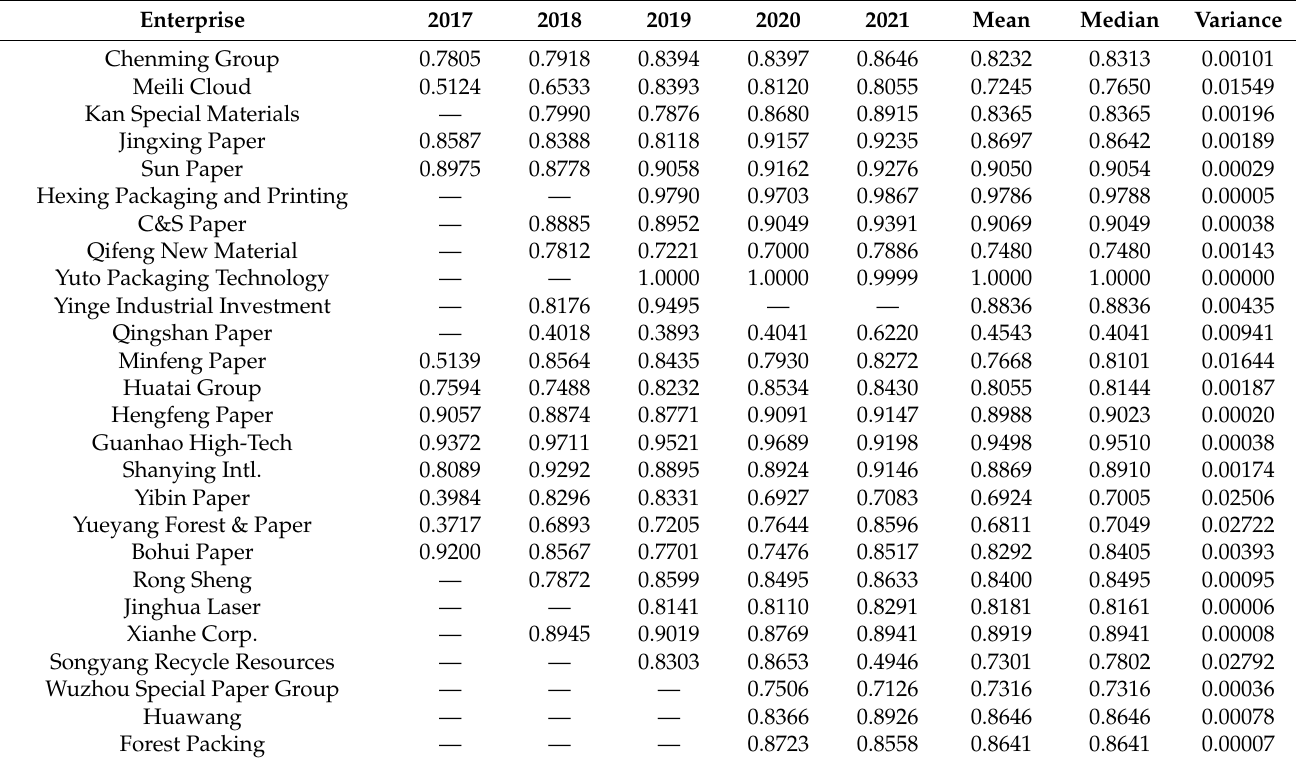
Table 2. Green emission scores in the paper industry from 2017 to